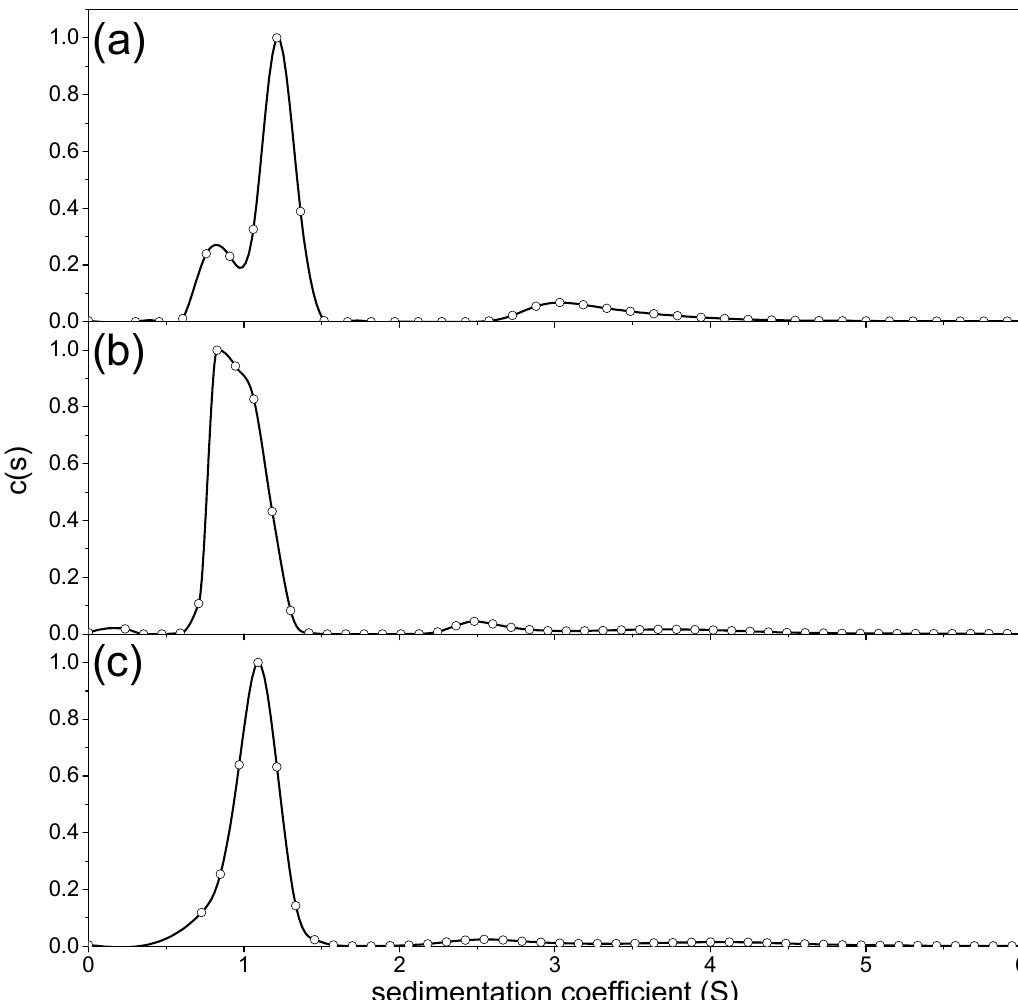
Figure 2. SEDFIT c(s) vs. s sedimentation coefficient distribution profiles obtained at 2 mg/mL ( a ) NJBTF1, ( b ) NJBTF 2, ( c ) NJBTF3. Maximum values for c(s) were normalised for comparison purposes. Solvent: phosphate chloride buffer (pH 7.0, I = 0.1 M), temperature = 20.0 °C.